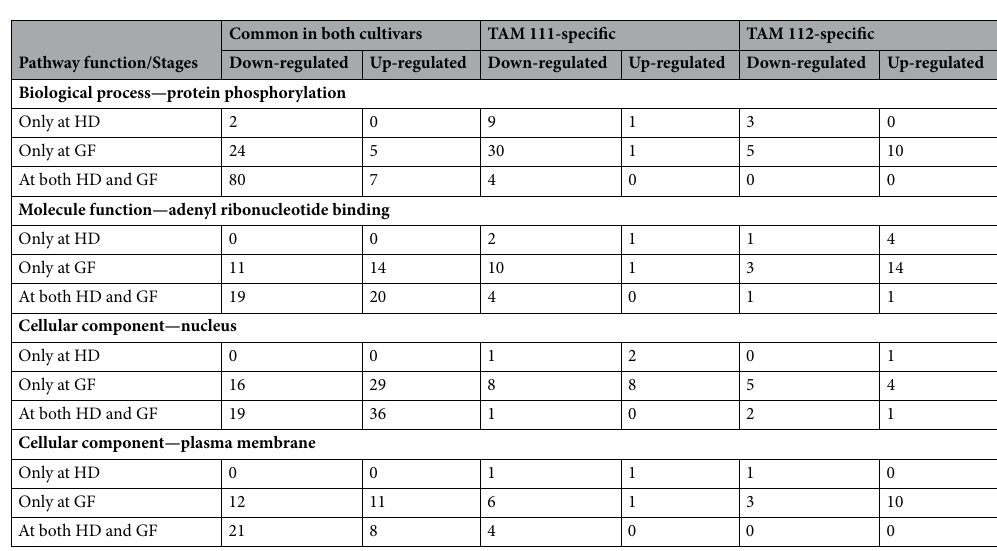
Table 3. Regulation of dry–wet differentially expressed genes (DEGs) involved in biological process, molecule functions and cellular components of TAM 111 and TAM 112 under water deficit stress at heading (HD) and grain filling (GF)